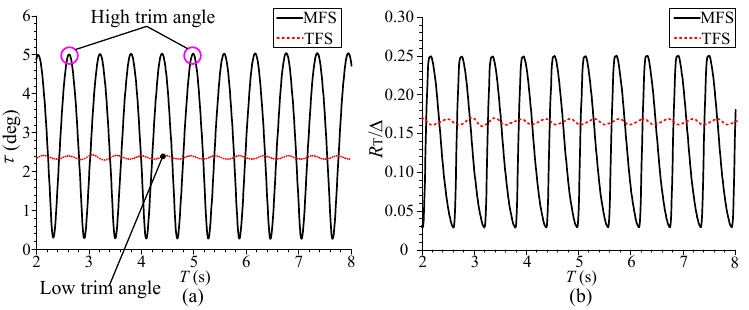
Figure 16. Oscillation comparisons when L cg /L m = 0.38: ( a ) trim angle; ( b ) total resistance.